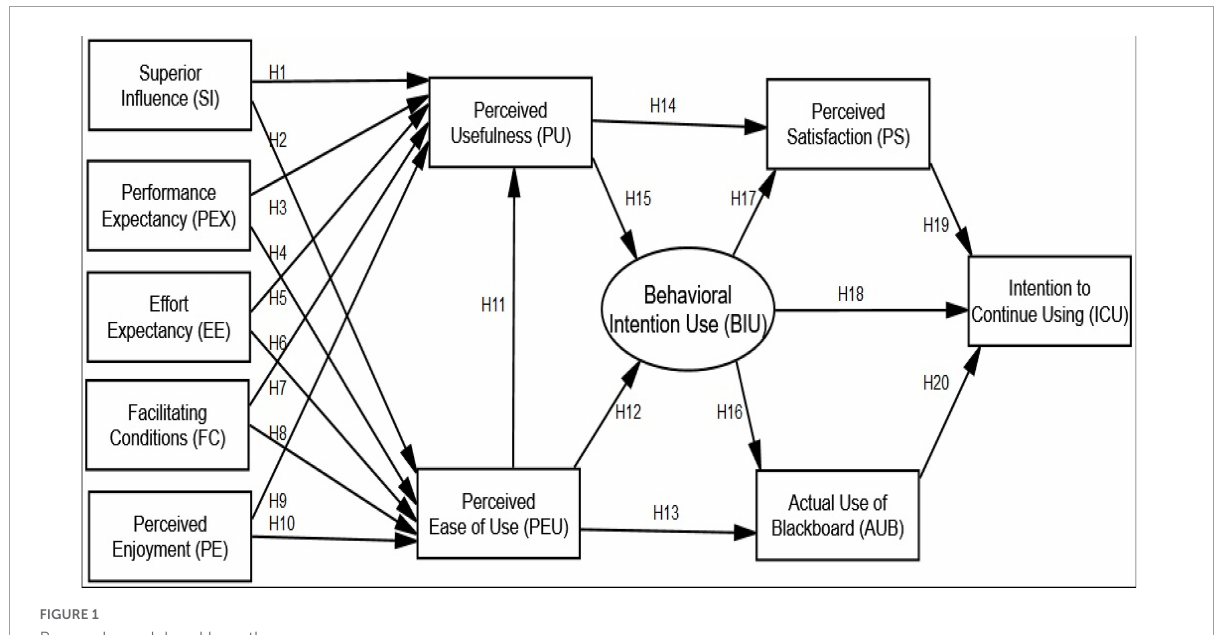
FIGURE1 Research model and